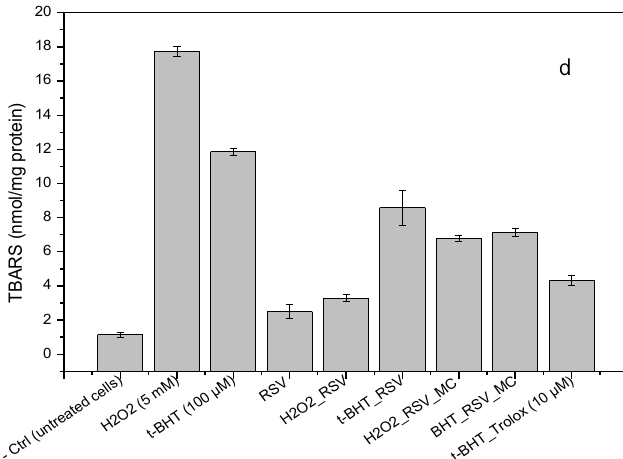
Figure 9. Biological responses of macrophages upon co-incubation with microcapsules: ( a ) Nitrite levels in supernatants of 24 h cultures on RAW macrophages pre-stimulated with LPS (0.5 μg/mL); RSV concentration used for this assays was 10 µM; ( b ) Effect of RSV and RSV-loaded microcapsules on the ROS production after co-incubation with zymosan A-activated macrophages. Phagocytosis assay, ( c1 ) blank microcapsules in co-culture with RAW macrophages and ( c2 ) RSV-loaded microcapsules (20X). ( d ) Effect of RSV and RSV-loaded microcapsules on H 2 O 2 and t -BHT-induced changes in TBARS levels on RAW macrophages.